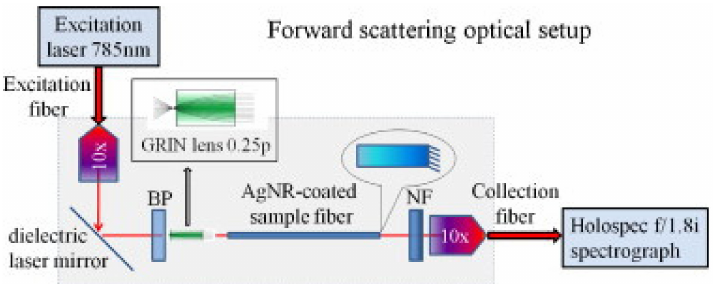
Figure 14. Schematic of the fiber-based SERS probe in forward scattering mode. The fiber was coated by AgNRs array on the tip. BP: Bandpass and NF: Notch filter. Reprinted with permission from Ref. [89]. Copyright 2011